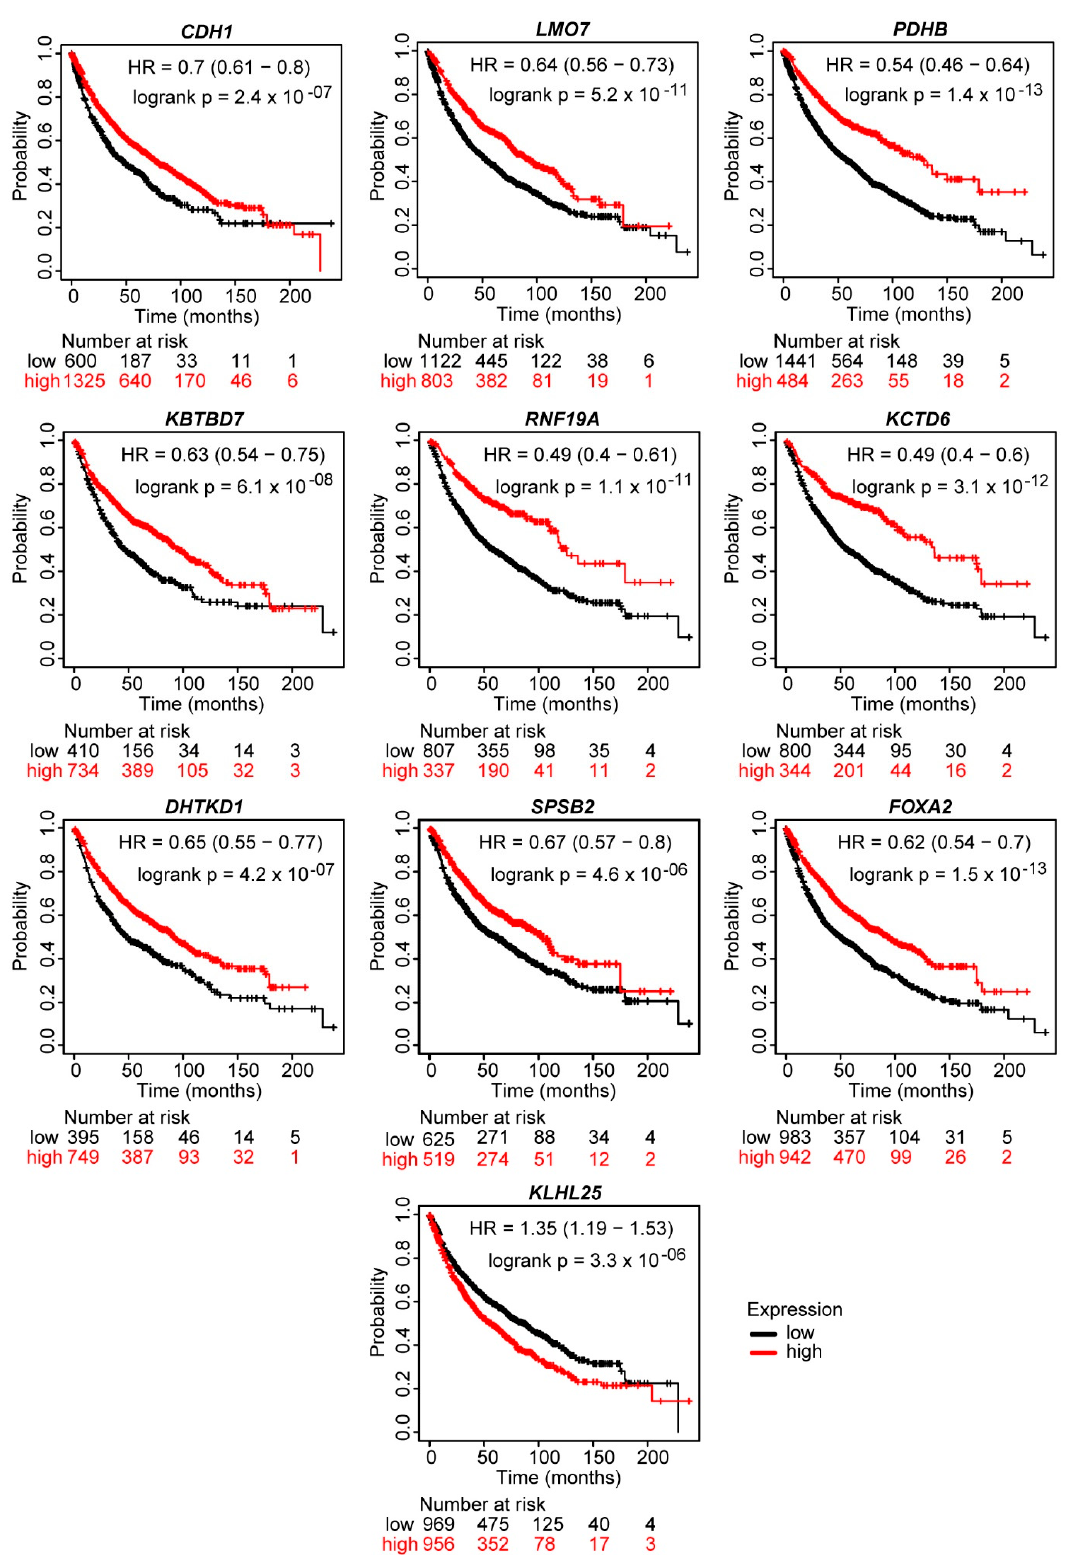
Figure 5. Prognostic value of genes associated with EMT in NSCLC. Kaplan–Meier association between the expression levels of module DEGs and overall survival of patients with NSCLC ( n = 1144) is displayed. Significance thresholds for potential gene biomarkers include a log-rank test p < 0.001 and a corrected p < 0.05 by BH FDR for the patient cut-off selection method. Low expression levels of CDH1 , LMO7 , PDHB , KBTBD7 , RNF19A , KCTD6 , DHTKD1 , SPSB2 and FOXA2 while high expression level of KLHL25 were associated with reduced overall